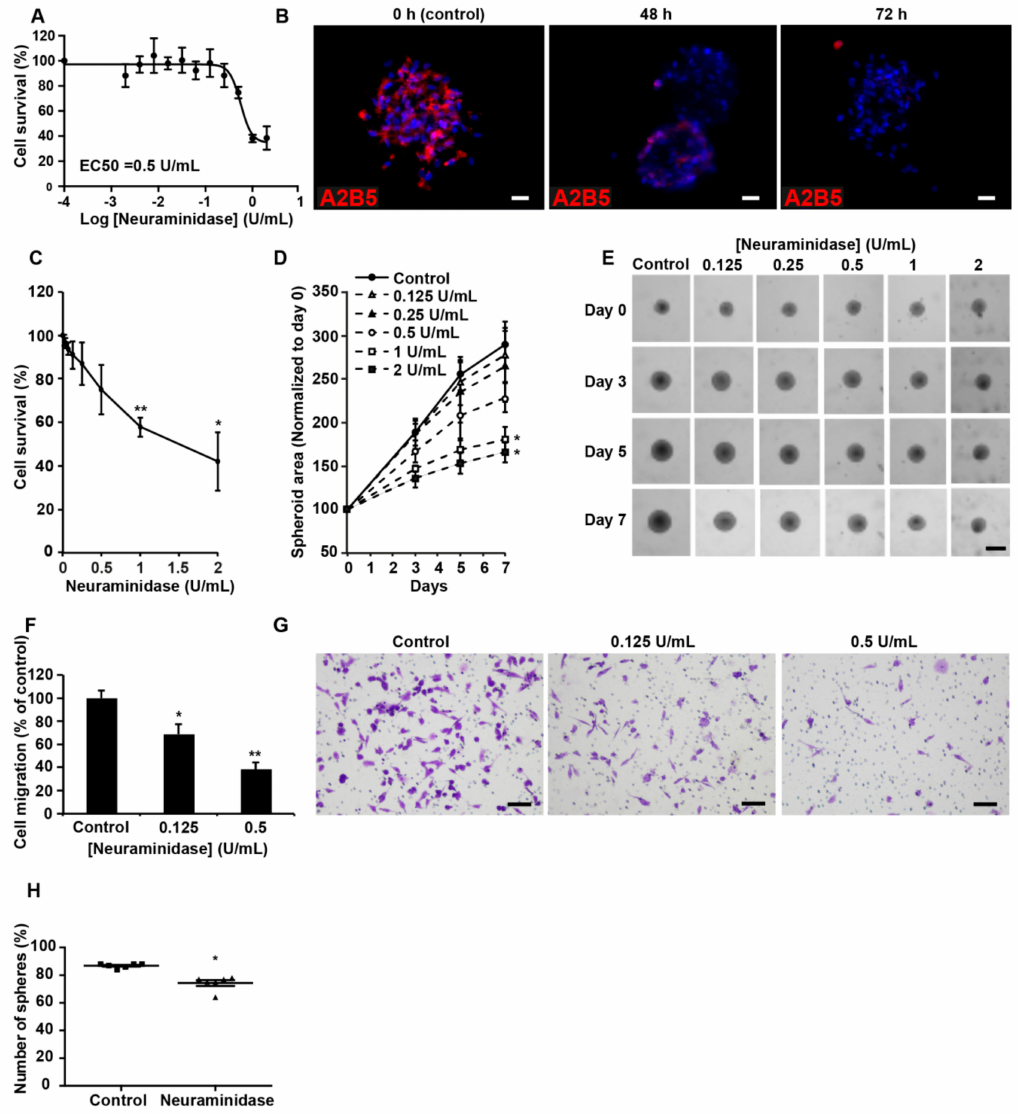
Figure4. SuppressionofA2B5immunoreactivityinhigh-A2B5-expressingcellsinducesadecreaseincell proliferation, migration, and clonogenicity. ( A ) A dose–response cytotoxicity assay of neuraminidase (10 − 4 to 1 U / mL) was conducted for 72 h to assess the viability of GBM9 cells grown as a 2D monolayer ( n = 3). ( B ) A2B5 staining (in red) on the GBM9 sphere control or that treated with 0.5 U / mL neuraminidase (EC50) for 48 and 72 h. ( C ) A dose-response cytotoxicity assay of neuraminidase (0 to 2 U / mL) was conducted for 7 days to assess the viability of GBM9 cells grown as 3D spheroids ( n = 3). ( D ) The GBM9 spheroid area was measured during the 7 days after neuraminidase treatment and normalized to Day 0. ( E ) Representative phase contrast images at Days 0, 3, 5, and 7 of the control and treated GBM9 spheroids. ( F ) Quantification of GBM9 cell migration using the transwell assay after neuraminidase treatment at 0.125 and 0.5 U / mL (EC50) for 6 h. The mean + SEM values of four independent experiments, each performed in duplicate, are shown. ( G ) Representative phase contrast images of control and treated migrating GBM9 cells. Scale bar = 50 µ m. ( H ) Self-renewal capacity was evaluated by limiting dilution assay in 96-well plates. The scatter plot shows the percentage of spheres formed after 8 days of culture of GBM9 cells treated or not with 0.5 U / mL neuraminidase (EC50). Non-parametric Wilcoxon-Mann-Whitney test shows * p < 0.05, ** p <